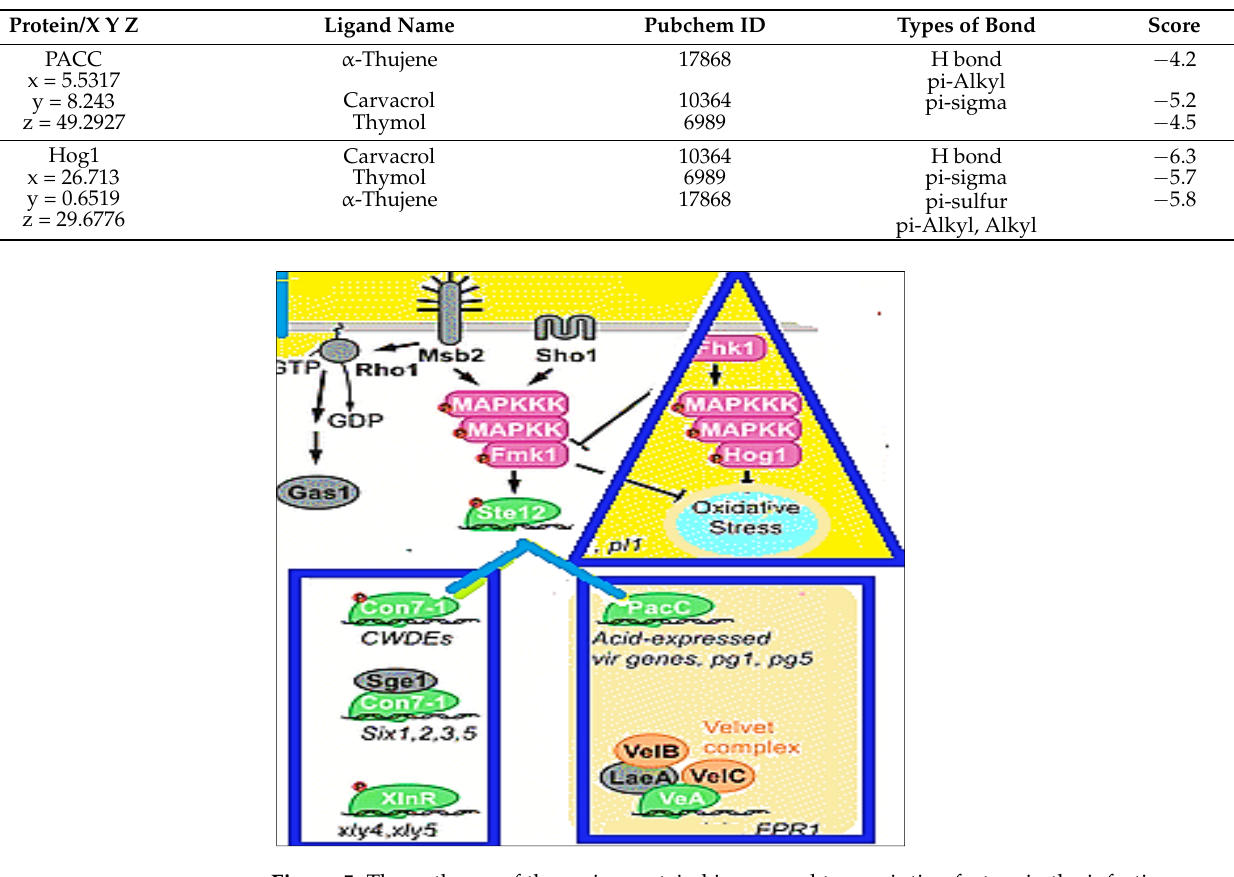
Figure 5. The pathway of the major protein kinases and transcription factors in the infection process of F. oxysporum [18].